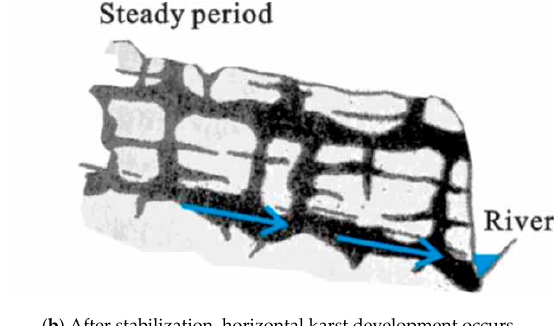
Figure 6. The underground river formation pattern controlled by the reverse fault. Image recreated from